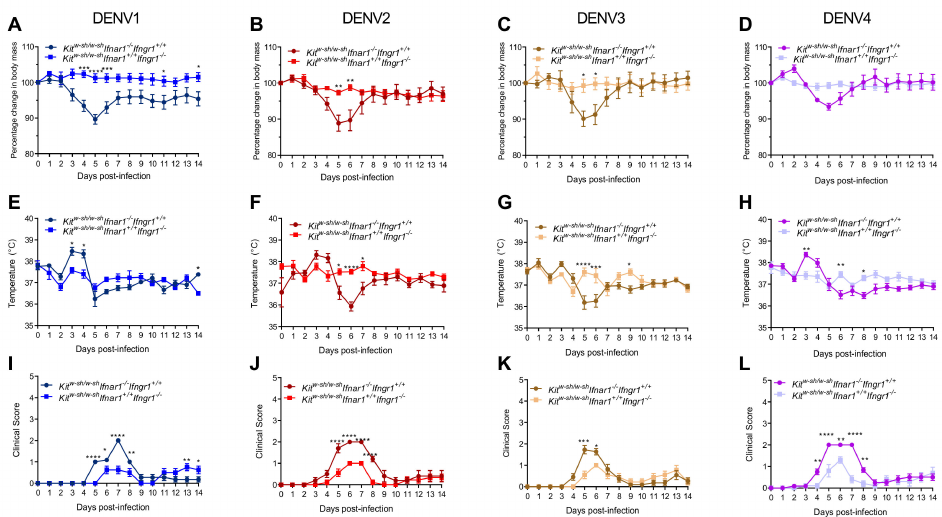
Figure 1. Type-I IFN deficiency worsens dengue disease severity compared to type-II IFN deficiency in MC-deficient mice. Kit W-sh/W-sh Ifnar1 − / − Ifngr1 +/+ and Kit W-sh/W-sh Ifnar1 +/+ Ifngr1 − / − mice were infected with 1 × 10 6 PFU of DENV1–4 (EDEN strain) by i.p. injection. Change in ( A – D ) body mass, ( E – H ) body temperature, and ( I – L ) clinical scores were recorded every day for two weeks. Data represent mean ± SEM, * p < 0.05, ** p < 0.01, *** p < 0.001, and **** p < 0.0001, by two-way ANOVA with Holm-Sidak’s post-test. For all panels, n = 8–9 mice per